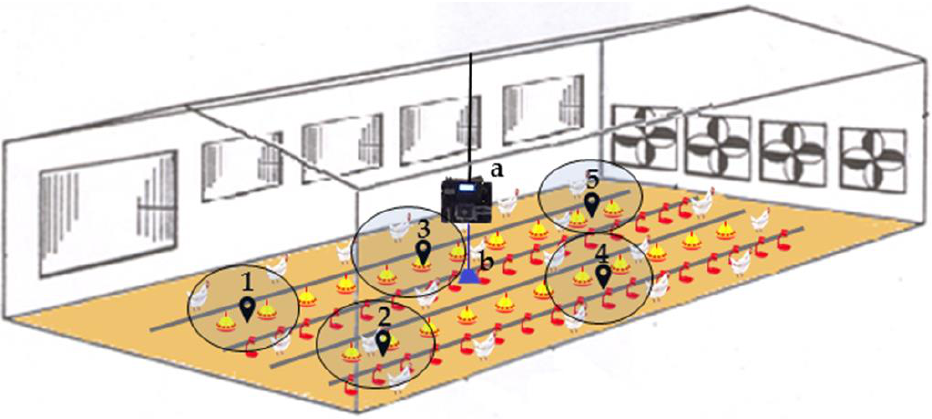
Figure 1. Illustration of the faeces sampling zones (1–5), the position of the device within the shed ( a ), and the air collection point ( b ).